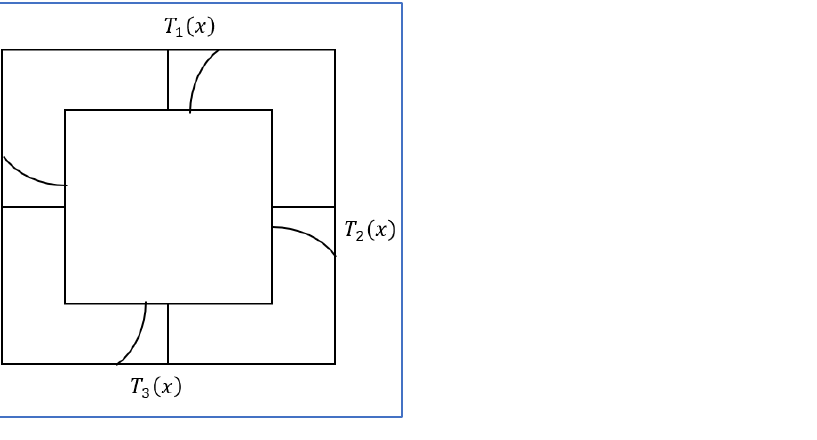
Figure 28. Temperature load loading mode. Note: T 1 ( x ), T 2 ( x ), T 3 ( x ), and T 4 ( x ) in the diagram are all the calculation relations of temperature in the thickness direction of each tower wall fitted by Formula ( 33).